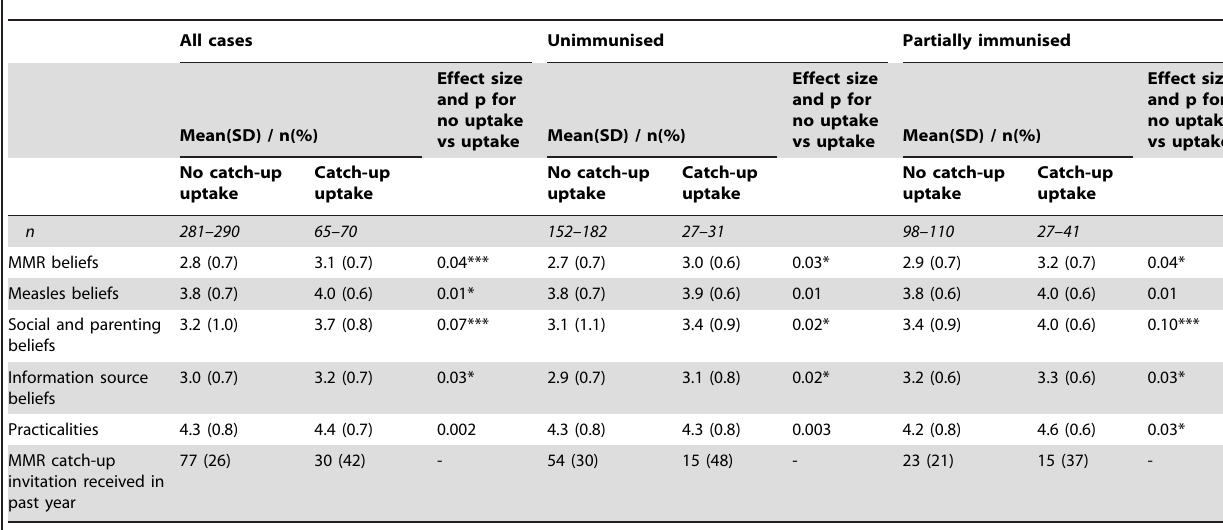
Table 3. Attitudes and catch-up invitation receipt by catch-up MMR